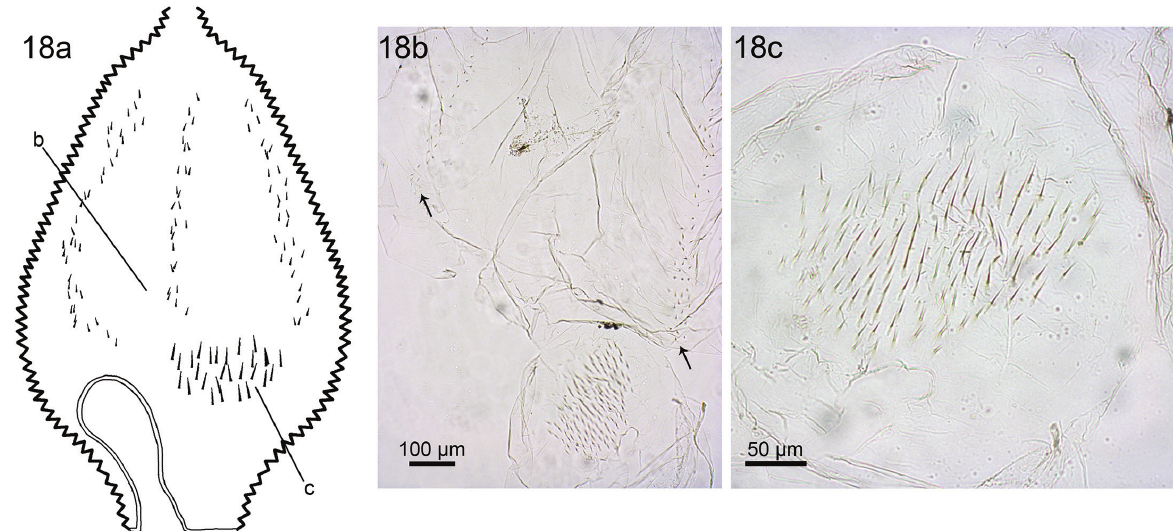
Figure 18. Noirotitermes noiroti . (a) Schematic drawing of P1 showing arrangement of spines. (b, c) Photomicrographs: (b) General view, arrows indicate the distal branches of spines; (c) Set of aciculiform spines in